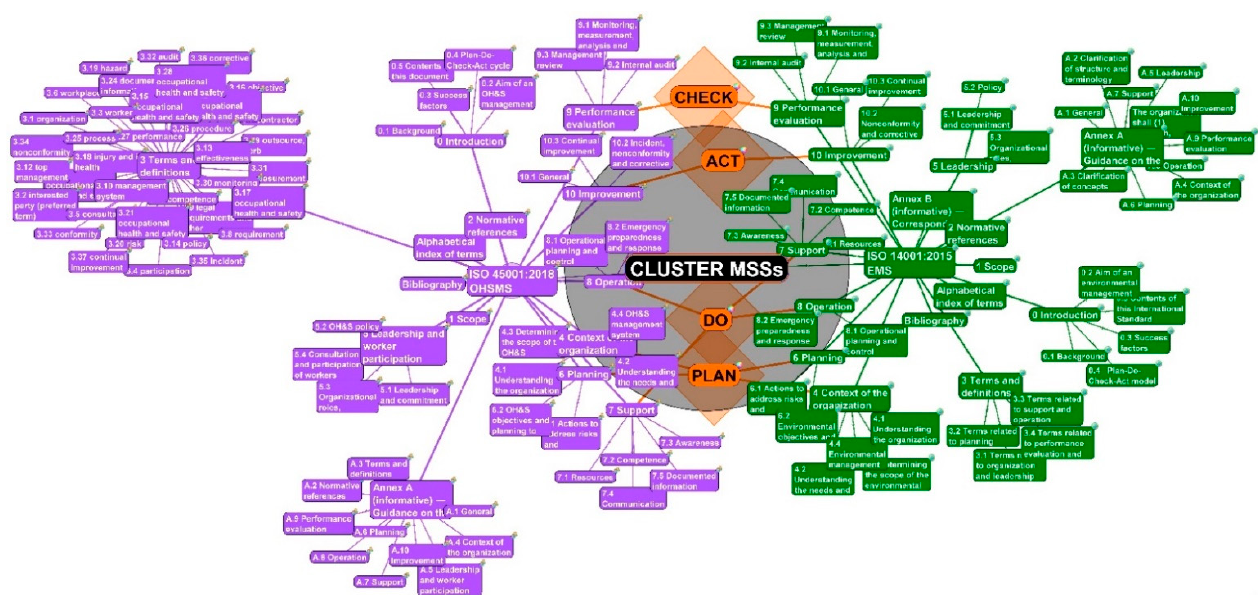
Figure 2. An activated PDCA cycle with four points, PLAN, DO, CHECK, and ACT, for both MSSs with their connections (source: authors).